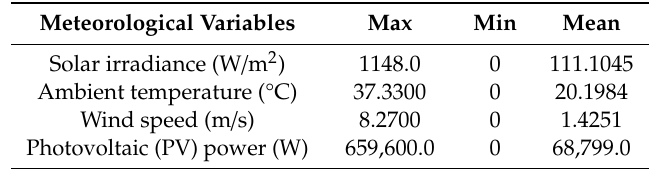
Table 1. Basic statistics of raw data.